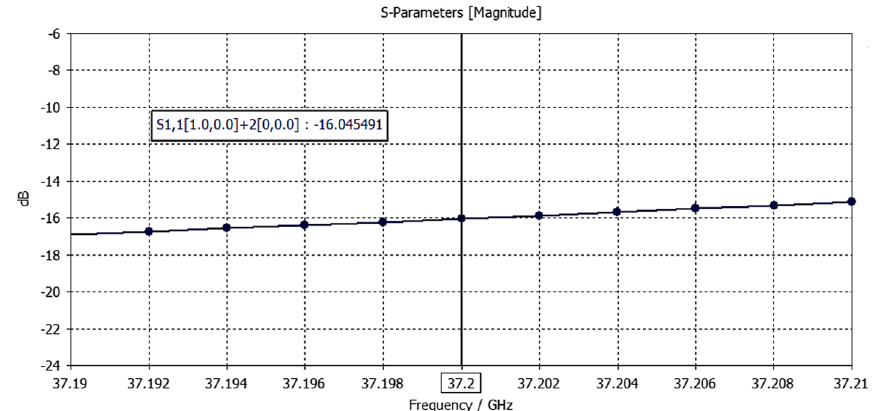
Fig. 9 S11 at frequency F = 37.2 GHz for antenna with non-identical irregularities